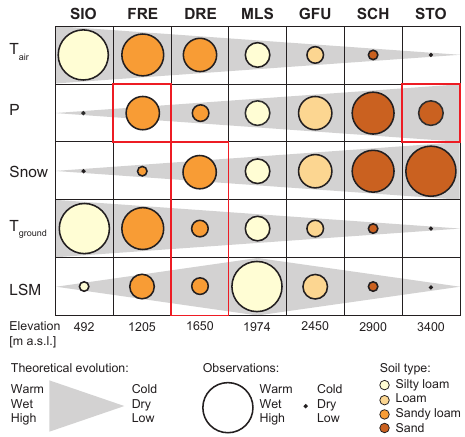
Figure 13. Generalized schematics of the evolution of air temper- ature, precipitation, snow duration, ground temperature and LSM with elevation. The circles represent the observations from 2015 (see Fig. 12), the grey area the expected theoretical evolution and the colour scale the soil type. The mismatches between model and observations are highlighted in